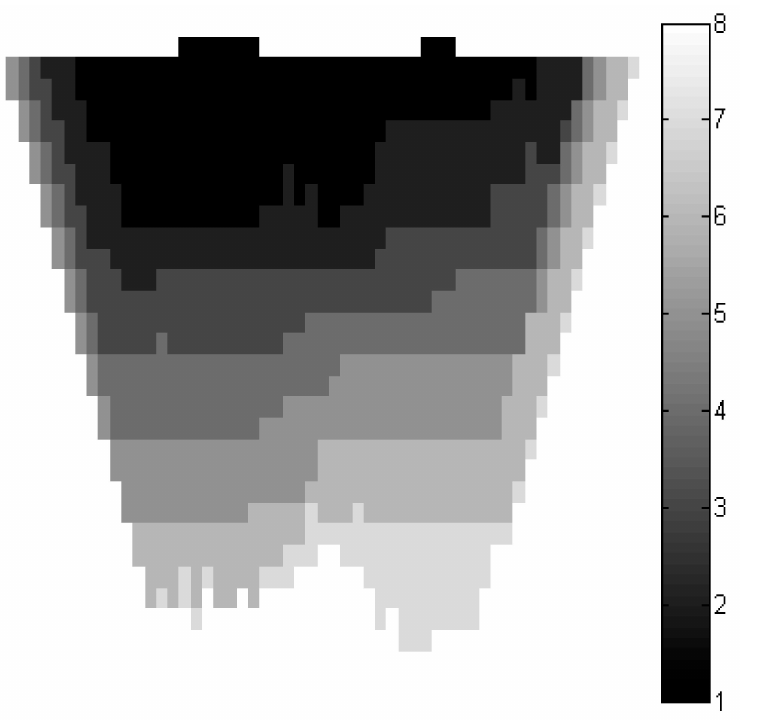
Figure 7. Production schedule of the deposit mine.